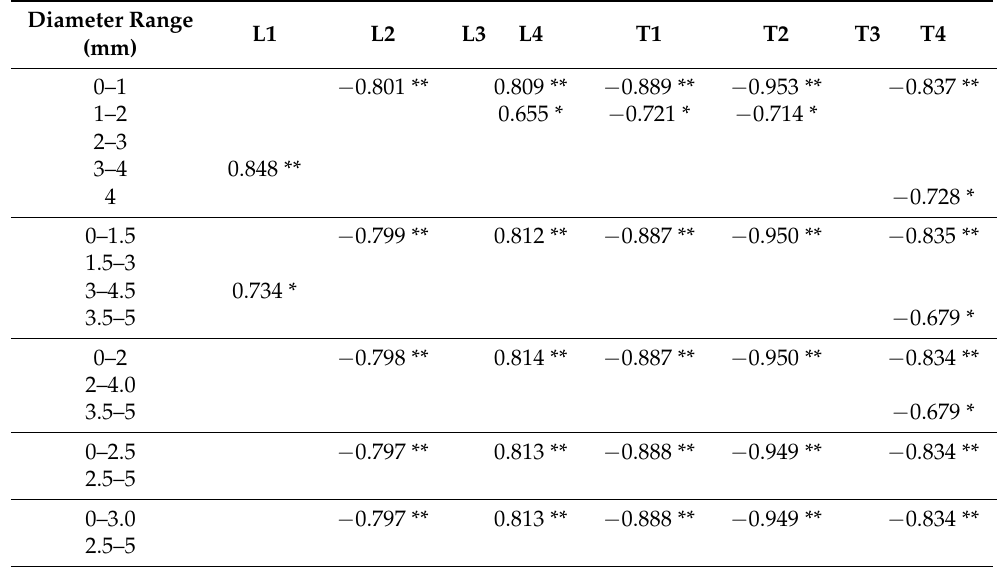
Table 2. Correlation between roots with different diameters and soil moisture